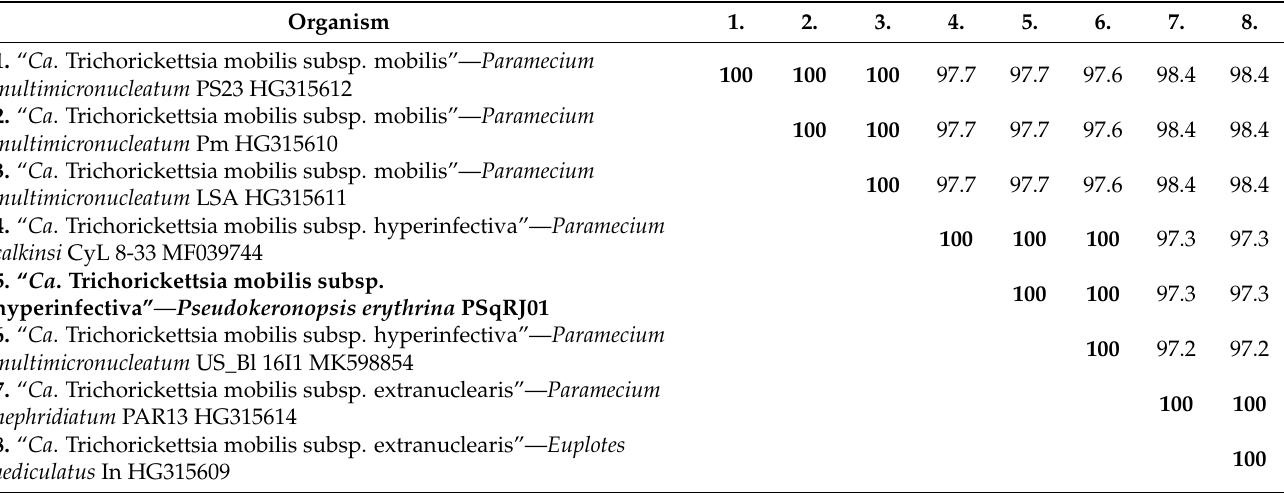
Table 1. Percent identity values of the 16S rRNA genes of “ Ca . Trichorickettsia” on the “full-sequence” matrix (1360 nucleotide positions). The newly characterized sequence of the endosymbiont of Pseudokeronopsis cfr. erythrina PSqRJ01 is highlighted in bold. Full identity values are highlighted in bold.